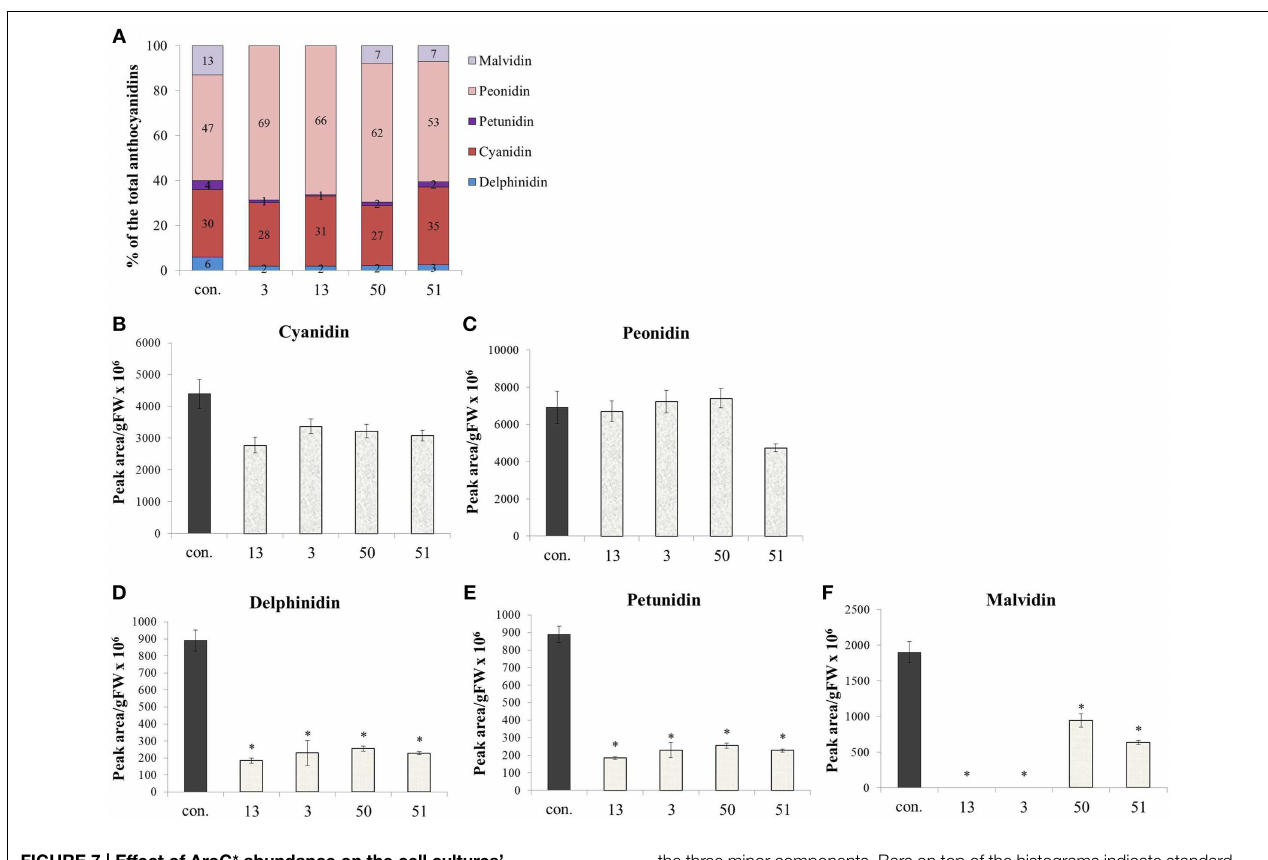
the three minor components. Bars on top of the histograms indicate standard errors (In the control n = 6 , including 3 samples from two lines, while in the AroG * lines, n = 3 ). Statistical significance was analyzed by One-Way ANOVA, followed by Dunnett’s post hoc test. Asterisks indicate P ≤ 0